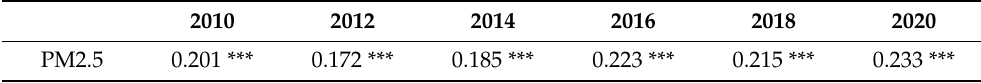
Table 2. Statistical tests of spatial autocorrelation using Moran’s